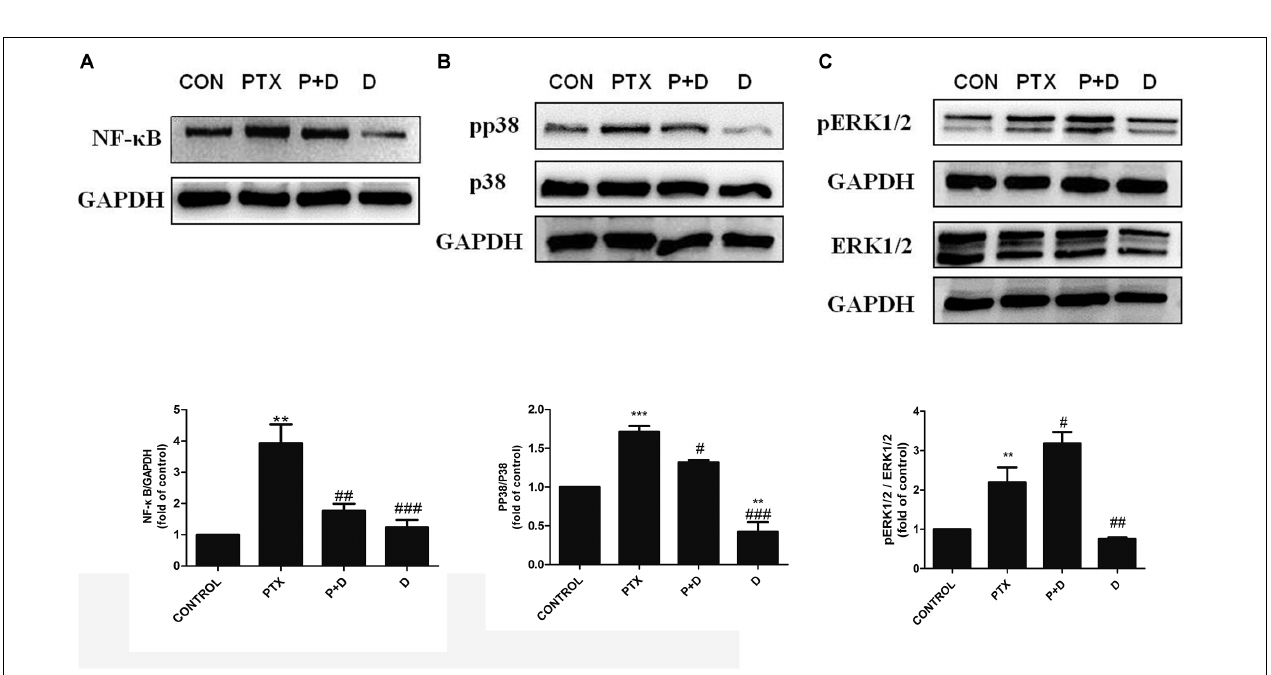
FIGURE 7 | Effect of duloxetine on NF- κ B, phosphorylation of p38 MAPK and ERK1/2 expression in the neuropathic mouse DRG following PTX treatment. (A) Duloxetine significantly decreased the expression of NF- κ B protein in the DRG of PTX-treated mice. (B) Duloxetine significantly decreased the expression of pp38 protein in the DRG of PTX-treated mice. (C) The ratio of pERK1/2 to ERK1/2 expression was significantly increased after PTX treatment, but duloxetine did not modify the p-ERK1/2 expression induced by PTX. ( ∗∗ p < 0.01 vs. control, ∗∗∗ p < 0.001 vs. control, # p < 0.05, ## p < 0.01, ### p < 0.001 vs. PTX). The data are presented as the mean ± SEM ( n =